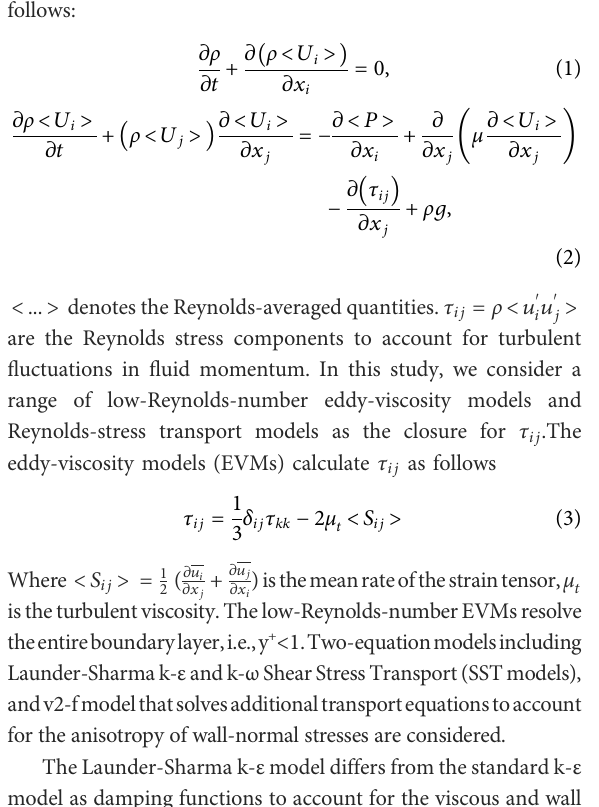
TABLE 1 Properties of liquid sodium. Property Value